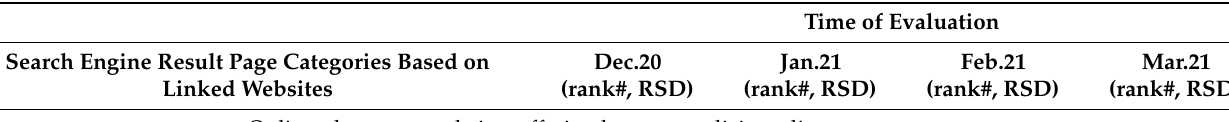
Table 2. Average search engine rank position of organic